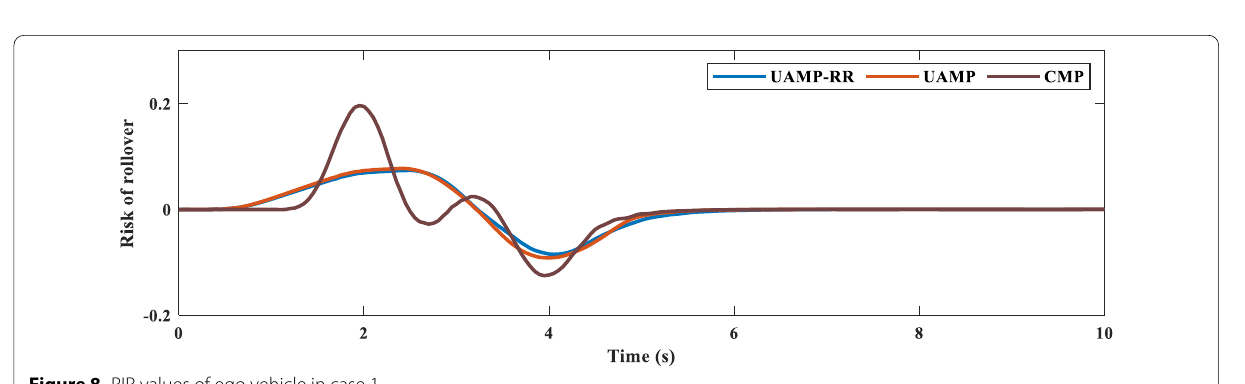
Figure 8 RIR values of ego vehicle in case